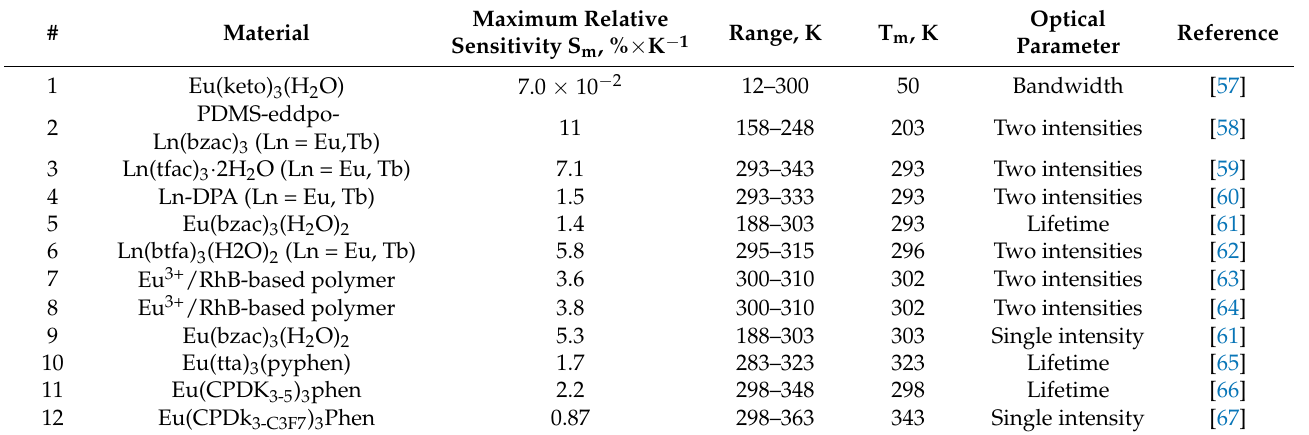
Table 1. Examples of existing thermosensors based on Ln(III)